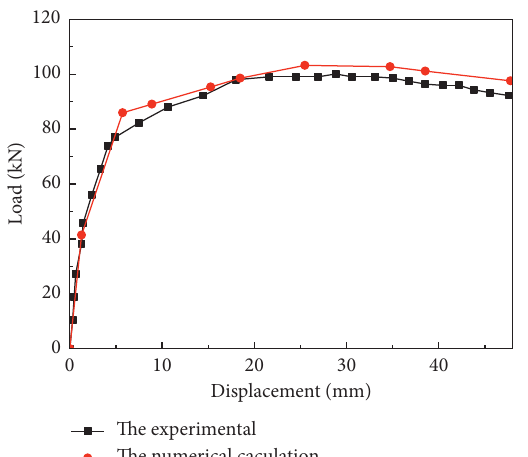
Figure 11: Comparison of the load-displacement curve between numerical calculation and experimental result of the reinforced concrete simply supported beam simplified